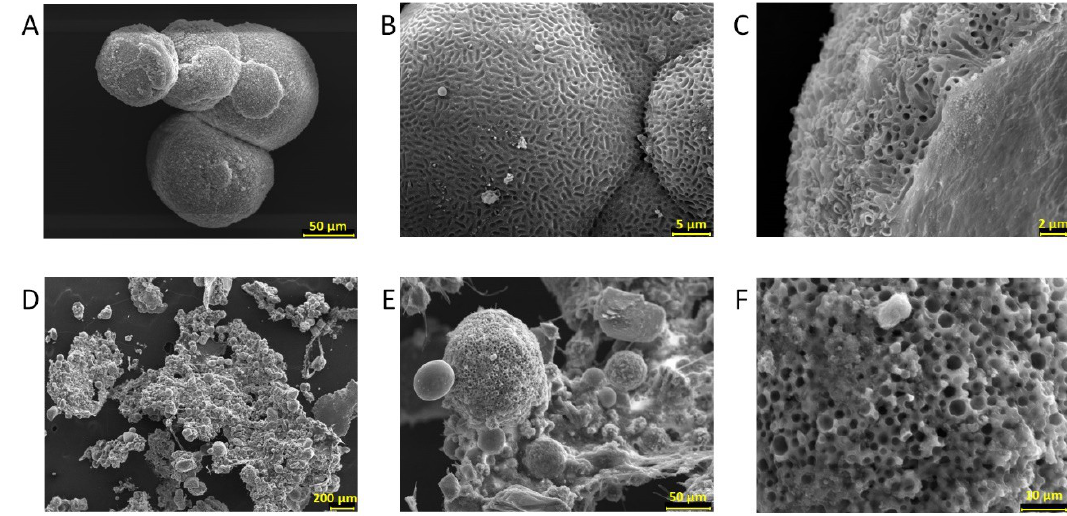
Figure 5. Scanning electron microscopy images of biominerals precipitated in the MC medium under constant ( A – C ) and variable ( D – F ) salinity conditions.